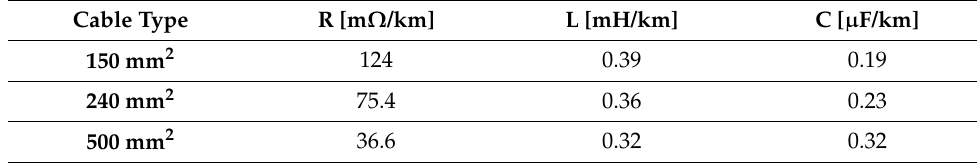
Table 1. Array cable data. Source: